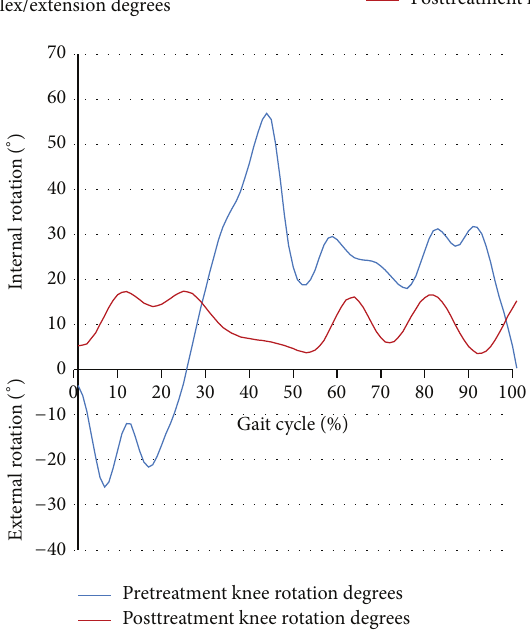
Figure 3: Knee joint kinematic